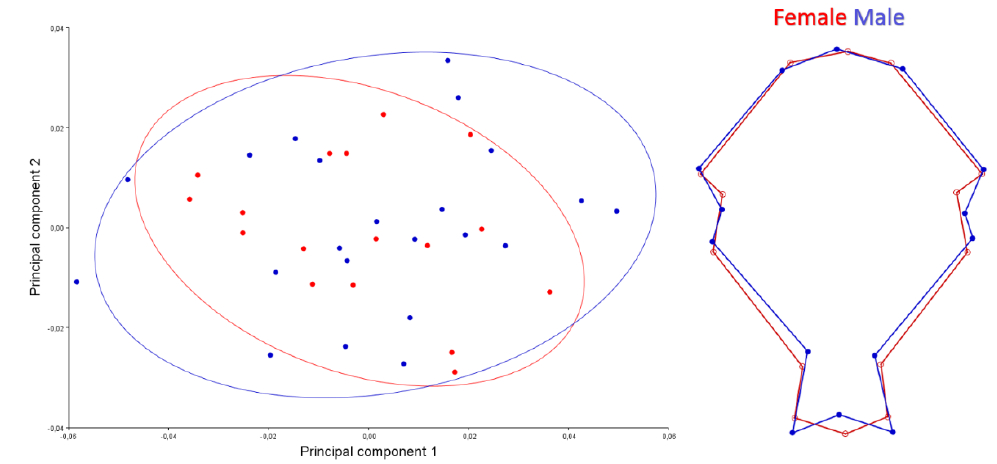
Figure 3. Scatter plot of PC1 (33.046) and PC2 (14.203) of quails for dorsal view ( left ). Wire-frame warp plots of changes in the cranial shape of quail, as mapped by 14 landmarks ( right ).